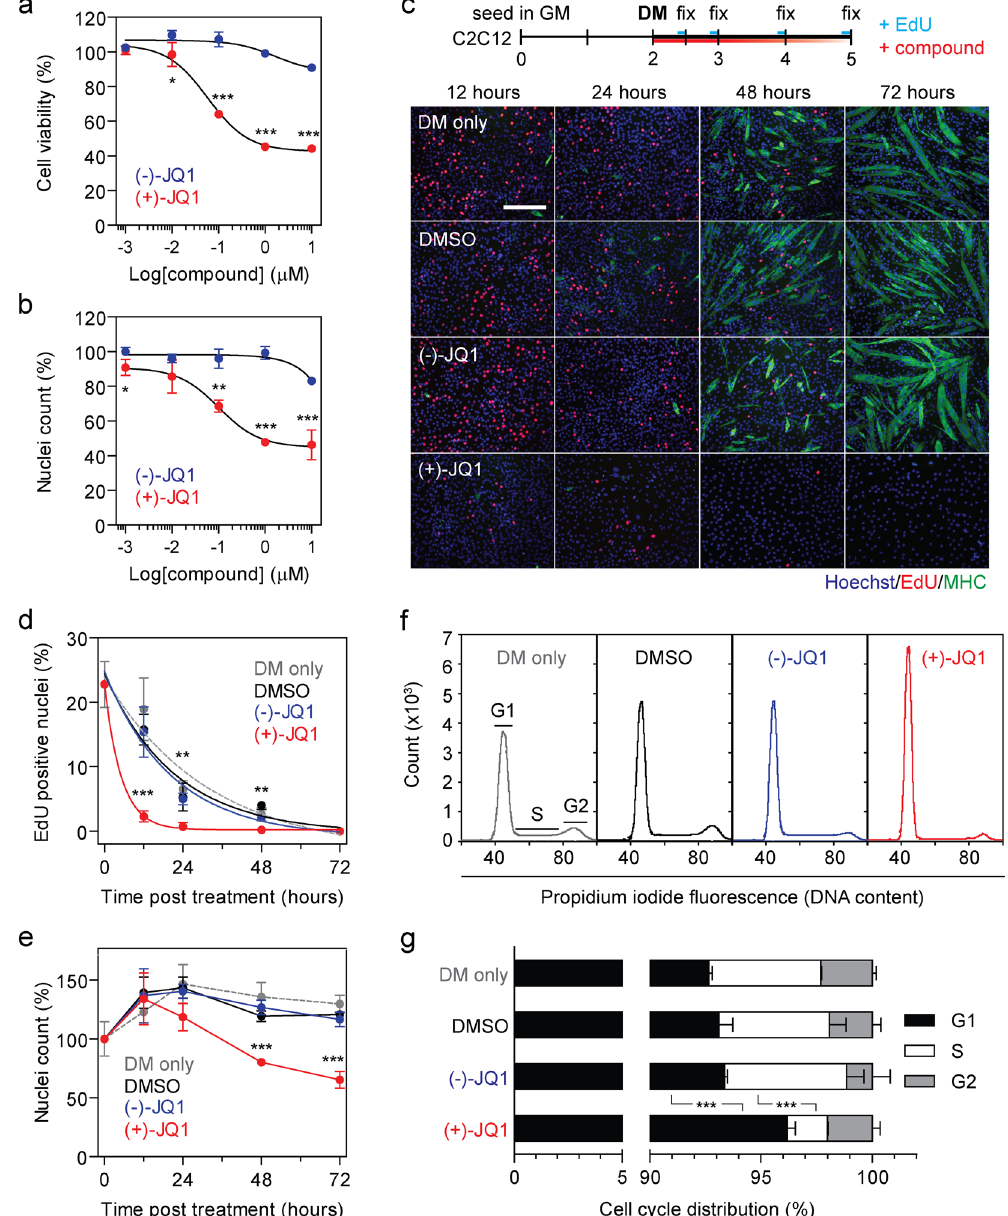
Figure 3. ( + )-JQ1 inhibits the cell cycle by G1 arrest in differentiating myoblasts. C2C12 cultures were treated with ( + )-JQ1, or the ( − )-JQ1 inactive enantiomer, over a range of concentrations (1 nM to 10 µ M) and cell viability assessed by ( a ) MTS assay, and ( b ) nuclei counting. Cell cycle progression was assessed by EdU incorporation assay. ( c ) C2C12 cultures were switched to DM and treated with 1 µ M ( + )-JQ1, ( − )-JQ1, DMSO or untreated (DM only). Cells were fixed at 12, 24, 48 and 72 hours after treatment and pulsed with EdU 2 hours before fixation. EdU positive nuclei were stained with Alexa Fluor 555 and cultures immunostained for MHC. ( d ) The percentage of EdU positive nuclei was determined by cell counting. ( e ) Changes in the number of nuclei over time, and in response to compound treatment were determined by counting nuclei. ( f ) The effect of 1 µ M ( + )-JQ1 on cell cycle progression was determined by flow cytometry analysis of DNA content, ( g ) and the proportions of nuclei in G1, S and G2 phases quantified. Images were taken at 10 × magnification, scale bars indicate 50 µ m. Values are mean + / − SD, n = 4 representative fields of view for microscopy, n = 6 for MTS data, n = 3 cultures for flow cytometry (30,000 singlet events counted per sample), * P < 0.05, ** P < 0.01, *** P < 0.001 (Comparisons between two groups were tested using an unpaired t -test. Comparisons between multiple groups were tested using one-way ANOVA with Bonferroni post hoc test, and the result for the ( − )-JQ1 versus ( + )-JQ1 comparison